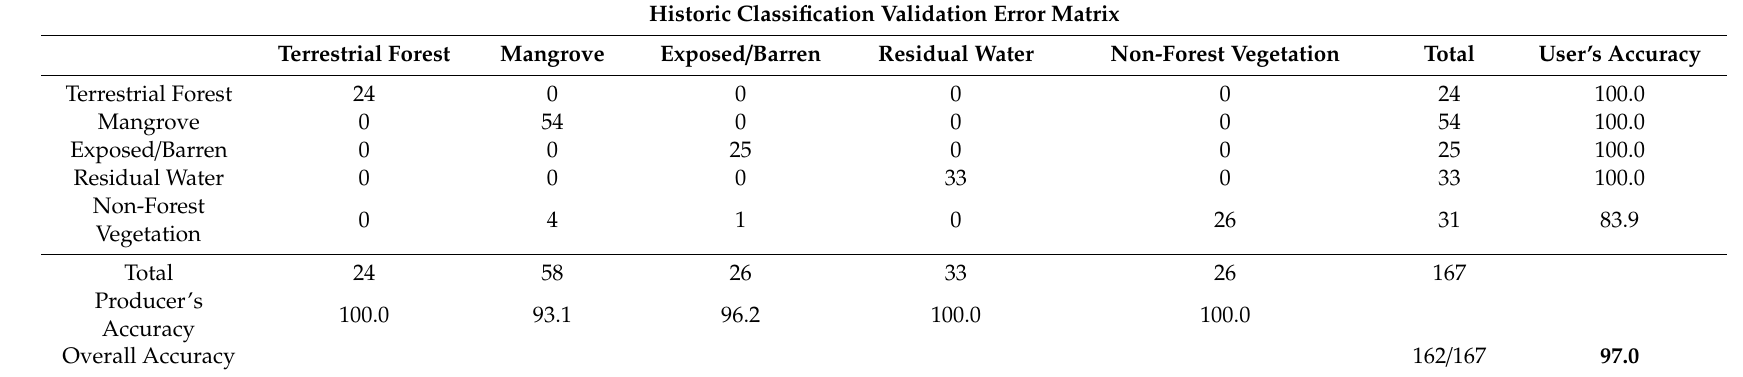
Table 7. Final Historic and Contemporary Validation Error Matrices, using validation CRAs